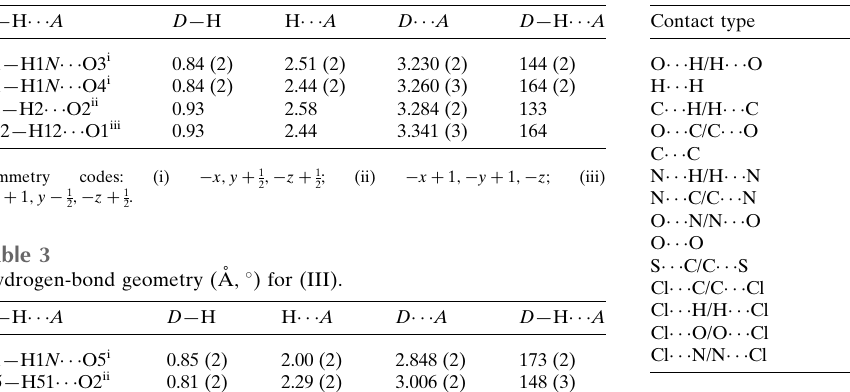
Table 4 Hirshfeld contact interactions (%)..